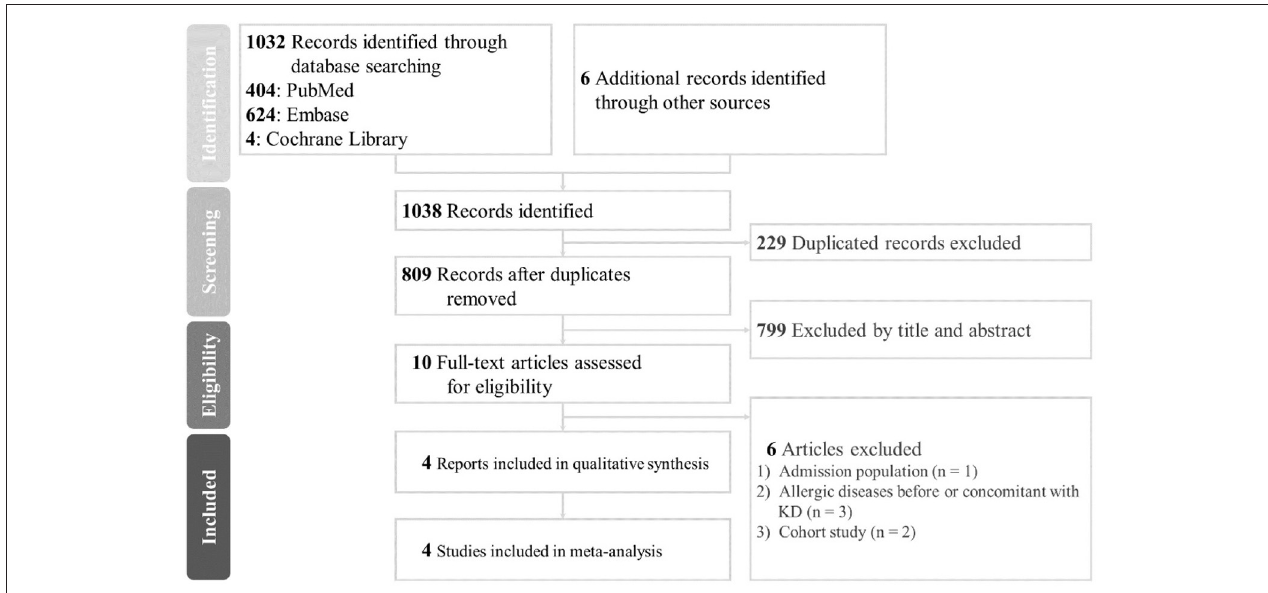
FIGURE 1 | Preferred reporting items for systematic reviews and meta-analysis (PRISMA) 2009 flow diagram; KD, Kawasaki